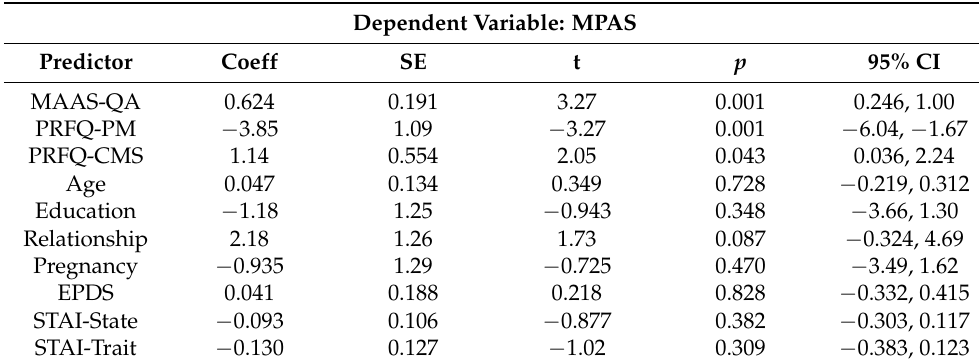
Table 4. Effects of each variable on MPAS included in the overall